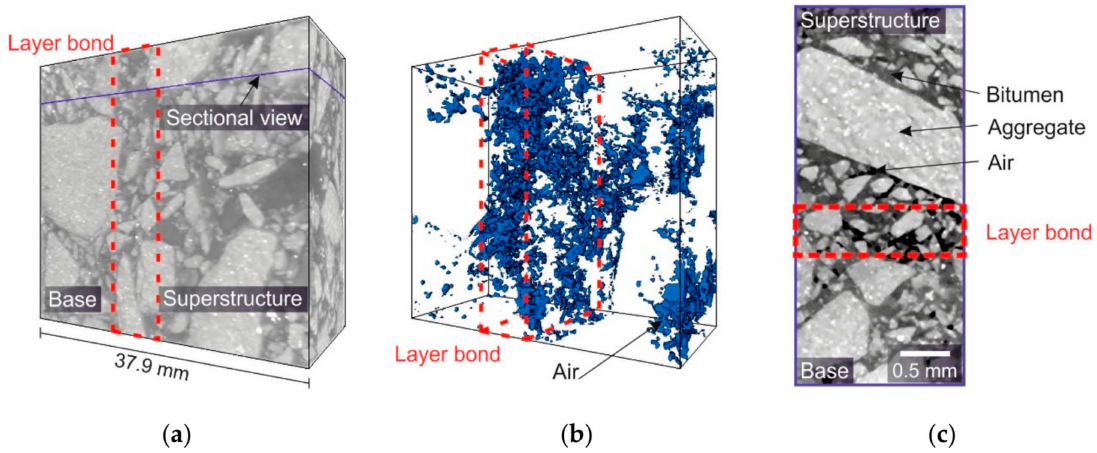
Figure 1. CT-scan of an asphalt composite sample with a resolution of 42.9 µ m: ( a ) 3D reconstruction of the sample which provides an overview of the measurement; ( b ) model of the entrapped air; ( c ) sectional view into the sample [18].